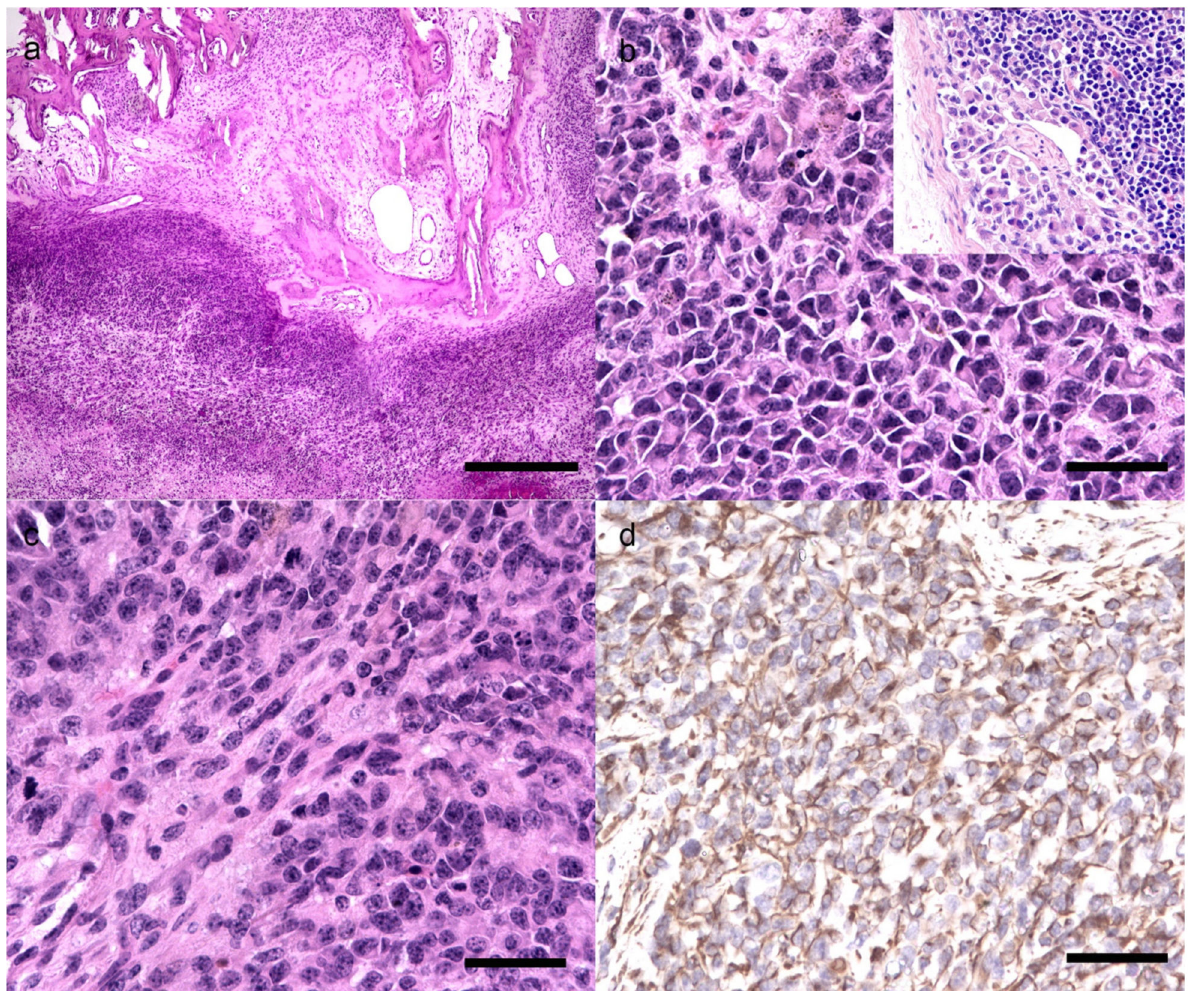
Figure 4. Histological and immunohistochemical features of undifferentiated sarcoma. ( a ) Solid lobules of neoplastic cells invading the bone trabeculae which have scalloped edges, HE, 40 × , bar 500 micron. ( b ) Round to polygonal neoplastic cells with intermediate N/C ratio, marked anisocytosis and anisokaryosis, and numerous mitotic figures, HE, 400 × , bar 100 micron; Inset: lymph node metastasis: neoplastic cells invading the subcapsular sinus. ( c ) Spindle to round neoplastic cells suggestive of highly heterogenous morphology of the neoplasm, HE, 400 × , bar 100 micron ( d ) Positive immunoexpression of vimentin in the cytoplasm of neoplastic cells, 400 × , bar 100